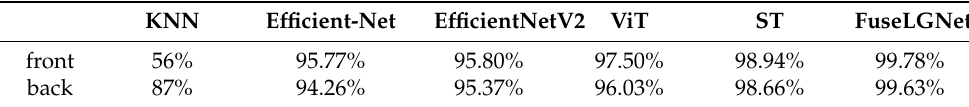
Table 3. Results on gait silhouette maps using the GAIT-IST